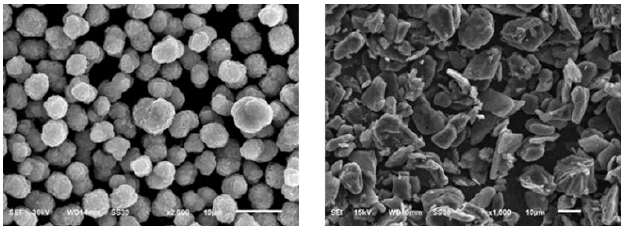
Figure 1. SEM images of cathode material SN1 and anode material A8- 5. Scale bar = 10